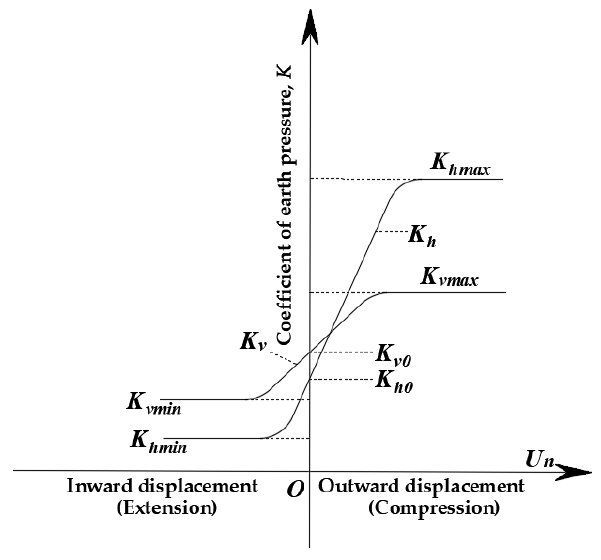
Figure 9. Ground reaction curve [24].